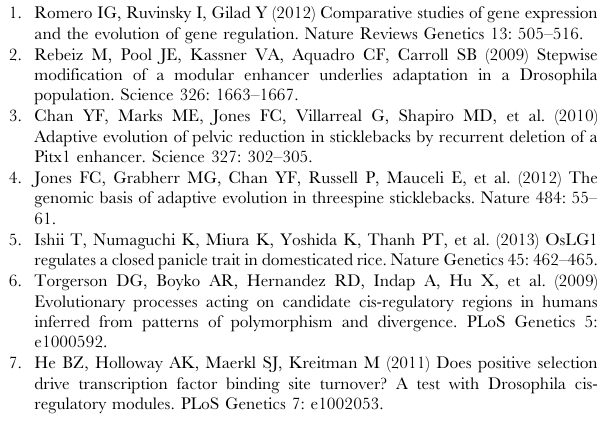
Table S1 Strains used in this work. Table S2 Read mapping statistics from yeast RNA-seq. Each set of rows reports the mapping statistics for reads from RNA-seq libraries used for a comparison of two yeast species. For a given set, in row headings, numerals indicate biological replicates, single species names indicate homozygotes, and species name pairs separated by a slash indicate diploid interspecies hybrids. Each row reports results from one library. Total reads, the full set of reads sequenced. Have polyT, the number of reads containing at least two consecutive Ts at only one end. Uniquely mapped, the number of reads mapping uniquely, with no mismatches, to the concatenated genomes of the two species of the set. Passed through filters, the number of reads whose poly-A tails were unlikely to have originated from oligo-dT mispriming to A-rich regions of the genome; see Methods. Table S3 Fitted models of cis -regulatory evolution in yeast pathways. Data are as in Table 1 of the main text except that results for all pathways are shown. Table S4 Fitted models of species regulatory evolution in yeast pathways. Data are as in Table 2 of the main text except that results for all pathways are